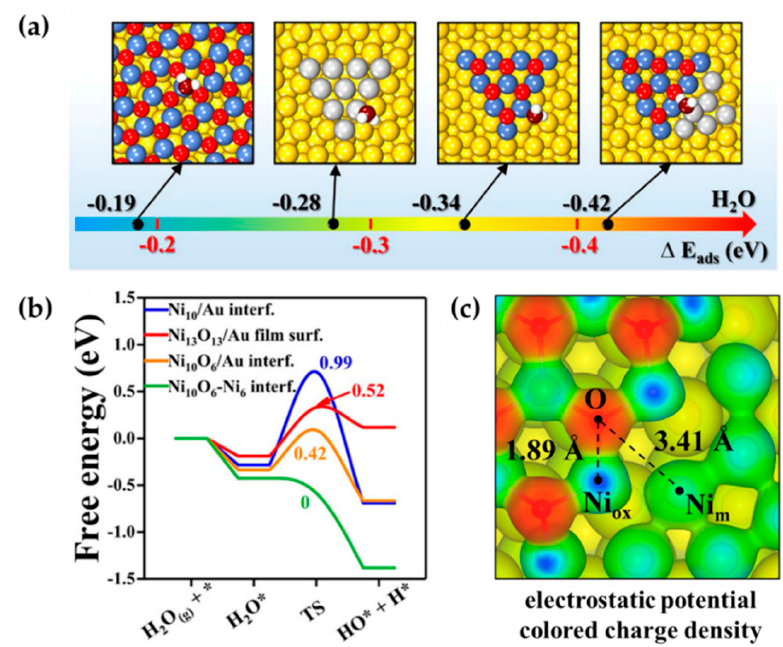
Figure 8. ( a ) Structures and adsorption of H 2 O on Ni 13 O 13 /Au(111), Ni 10 /Au(111), Ni 10 O 6 /Au(111), and Ni 10 O 6 -N i6 /Au(111). Color code: Au, yellow; metallic Ni, grey; oxidized Ni, blue; oxygen in NiO X , red; oxygen in H 2 O, brown; hydrogen, white. ( b ) Gibbs free energy diagram of H 2 O dissociation on the four surfaces (* indicated the adsorption site), based on PBE with vdW-DF, via VASP. ( c ) Electrostatic potential colored electron density of Ni 1 0 O 6 -N i6 /Au(111). Adapted from reference [85] with permission.